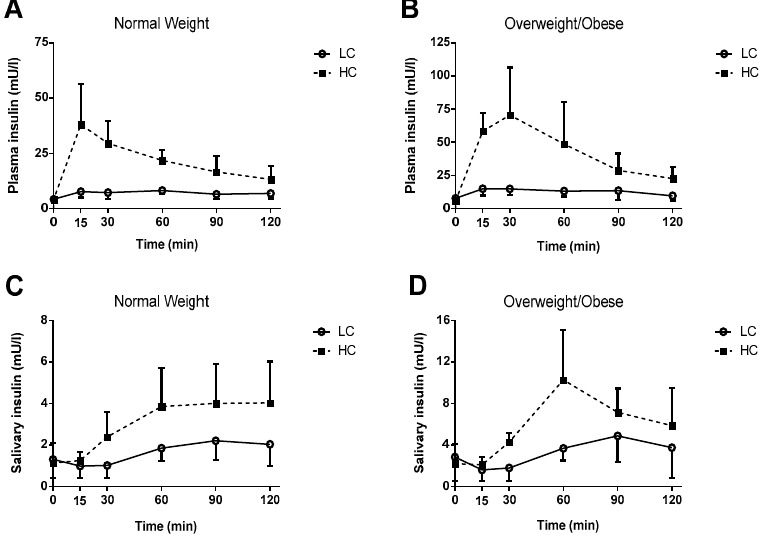
Figure 1. Two-hour plasma and saliva insulin responses to low-carbohydrate (LC) and high-carbohydrate (HC) breakfast meals in normal weight (NW) and overweight/obese (OO) participants. ( A ) Plasma insulin levels in NW participants; ( B ) Plasma insulin levels in OO participants; ( C ) Saliva insulin levels in NW participants; and ( D ) saliva insulin in OO participants. Statistical analyses were performed on the areas under the curve shown in Figure 2.